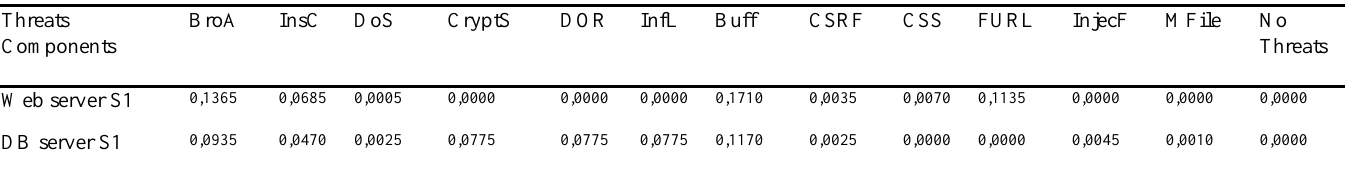
Table 6: The Impact Matrix S1 (IM S1)